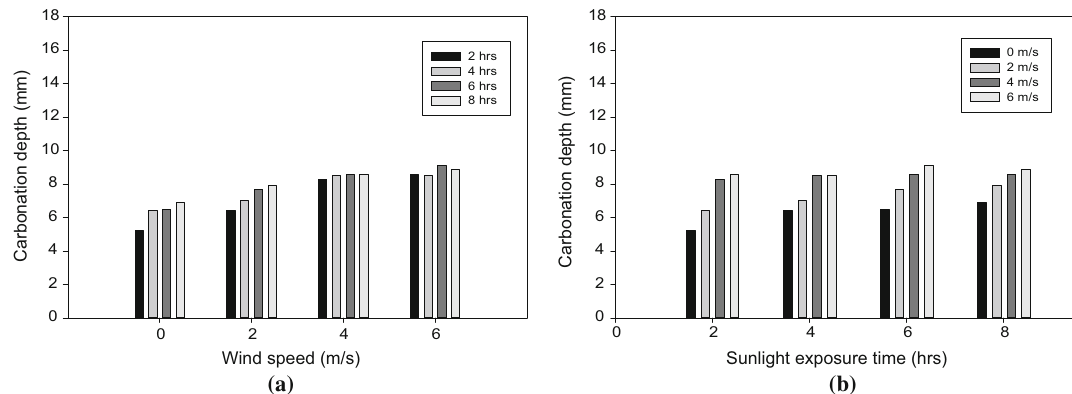
Fig. 2 Carbonation depth versus wind speed and sunlight exposure time. a Wind speed with 0, 2, 4, 6 m/s. b Sunlight exposure time with 2, 4, 6, 8 h.